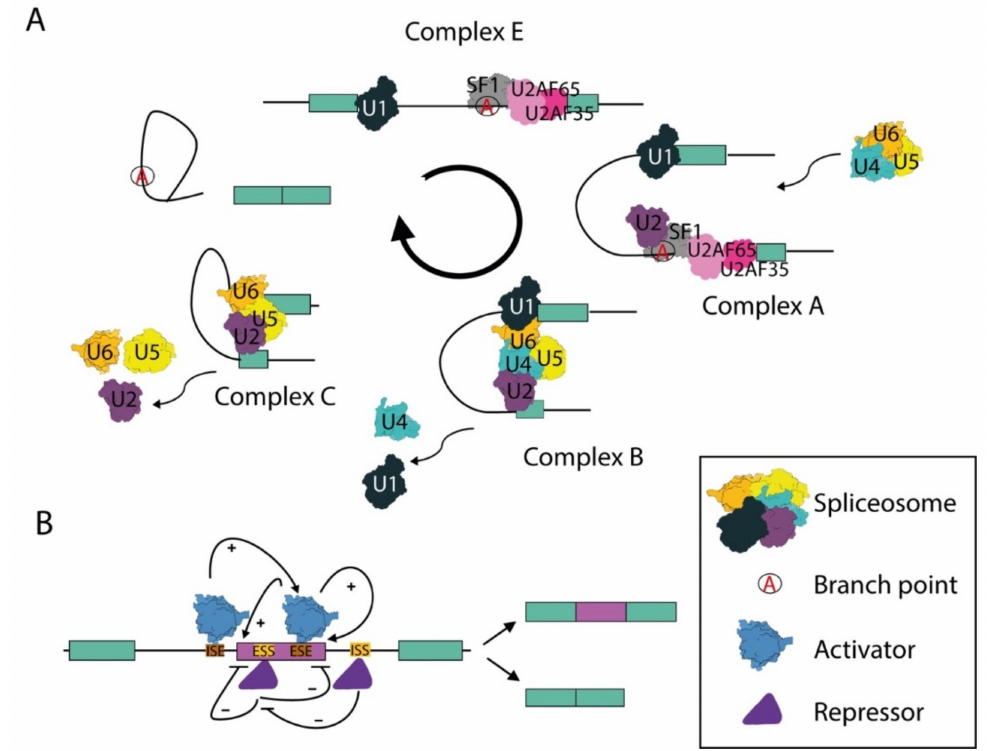
Figure 1. The splicing mechanism. ( A ) Schematic representation of the splicing reaction. In the first step, the U1 snRNP binds to the 5 (cid:48) splice site whereas SF1 and the U2AF complex bind the branch- point and the 3 (cid:48) splice site, respectively, resulting in the formation of the E complex. The subsequent binding of U2 snRNP at the branch-point, which replaces SF1, leads to the formation of the A complex (or pre-spliceosome). After recruitment of the tri snRNP U4/U6 and U5, the spliceosome assumes its B complex conformation, which is then remodeled through numerous protein–protein and protein– RNA interactions to acquire the catalytically active conformation (complex C) that promotes intron excision and exon joining. ( B ) Alternative splicing of variable exons is regulated by the presence of intronic and exonic splicing enhancers (ISE and ESE), which are bound by splicing activators (blue) that promote recognition of the splice sites by the spliceosome and the inclusion of the alternative exon (pink). Conversely, splicing repressors (purple triangles) bind to intronic and exonic splicing silencers (ISS and ESS) and repress inclusion of the alternative exon by hiding the splice sites and competing with the